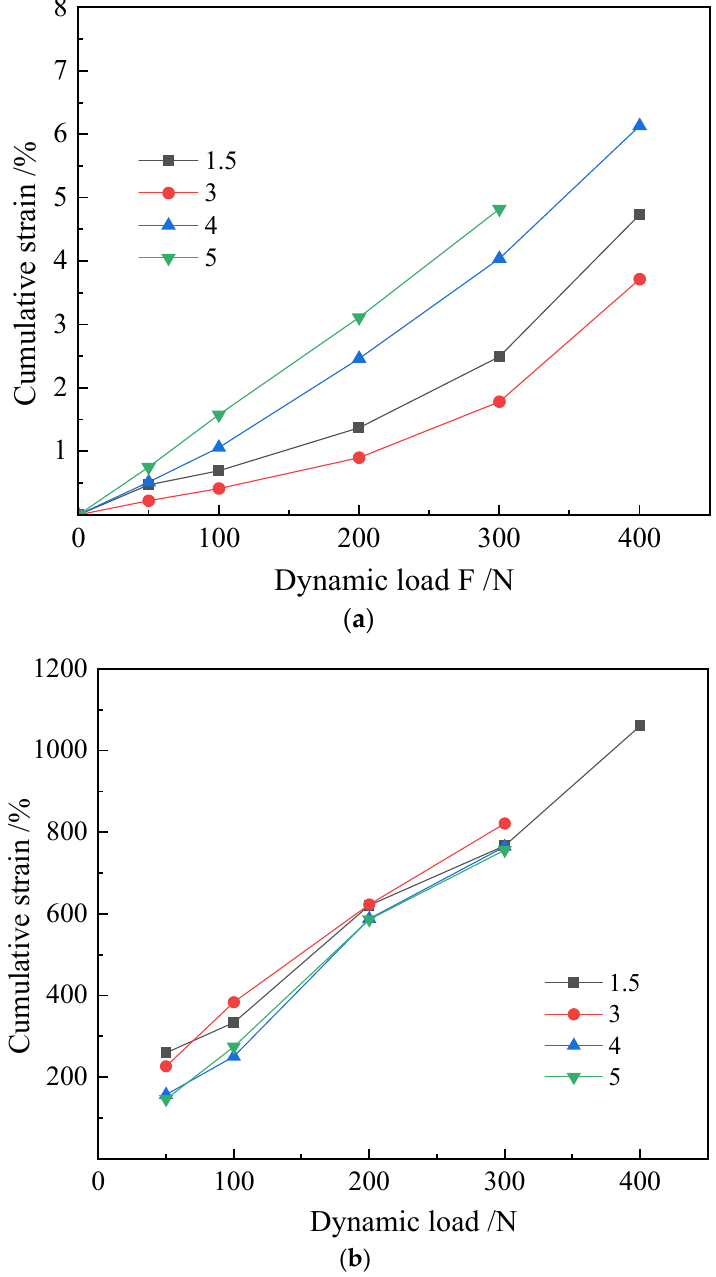
Figure 9. E-L scheme sample. ( a ) Cumulative strain curve, ( b ) resilience modulus Ed and dynamic load curve.